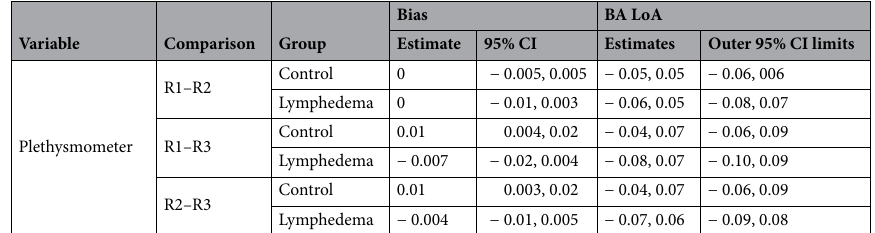
Table 2. Bias and BA LoA estimates with 95% CIs for interrater comparisons of the plethysmometer. Data is presented as estimated mean difference and respective 95% confidence interval in cubic milliliters (ml) supplemented by Bland–Altman Limits of Agreement. Bland–Altman Limits of Agreement is the mean difference ± 1.96 standard deviation of the difference. BA Bland–Altman, LoA Limits of Agreement, CI confidence interval, R1 rater 1, R2 rater 2, R3 rater 3.